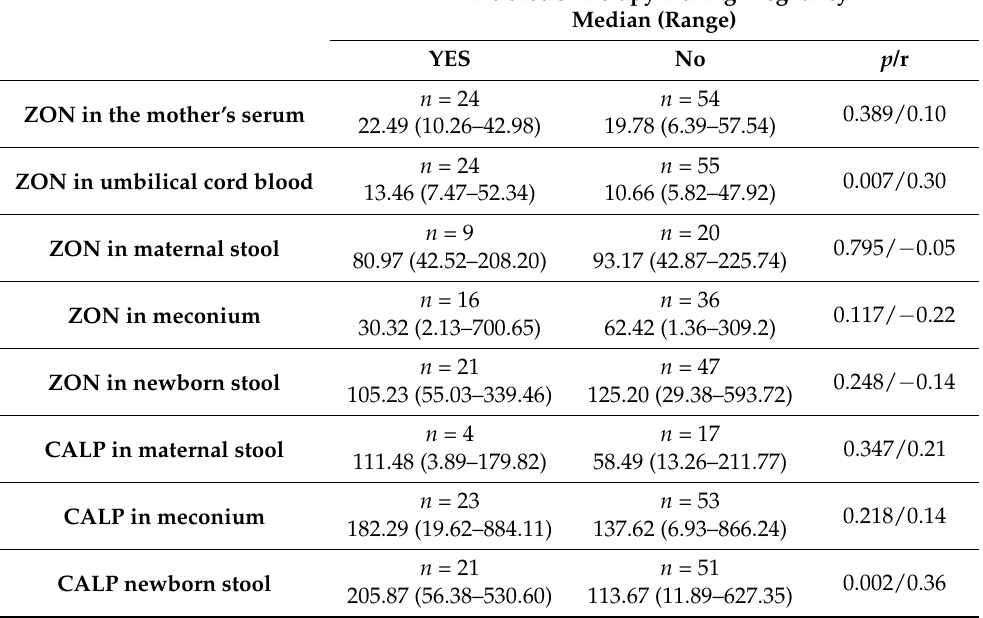
Table 4. Effects of antibiotic therapy during pregnancy on zonulin (ZON, ng/mL) and calprotectin (CALP, µ g/mL)